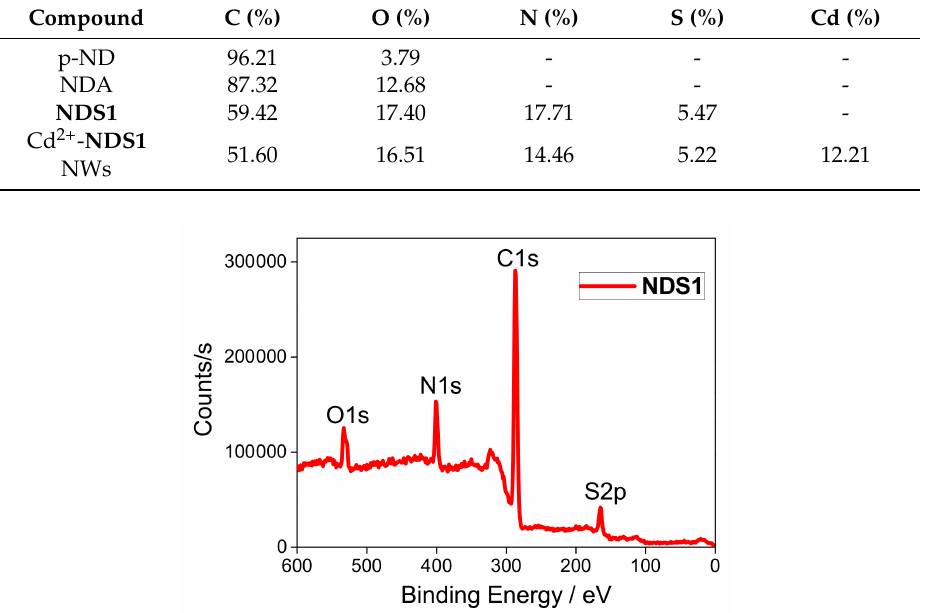
Figure 2. XPS spectrum of NDS1 confirms the presence of Carbon (C1s), Nitrogen (N1s), Oxygen (O1s) and Sulfur (S2p) atoms.